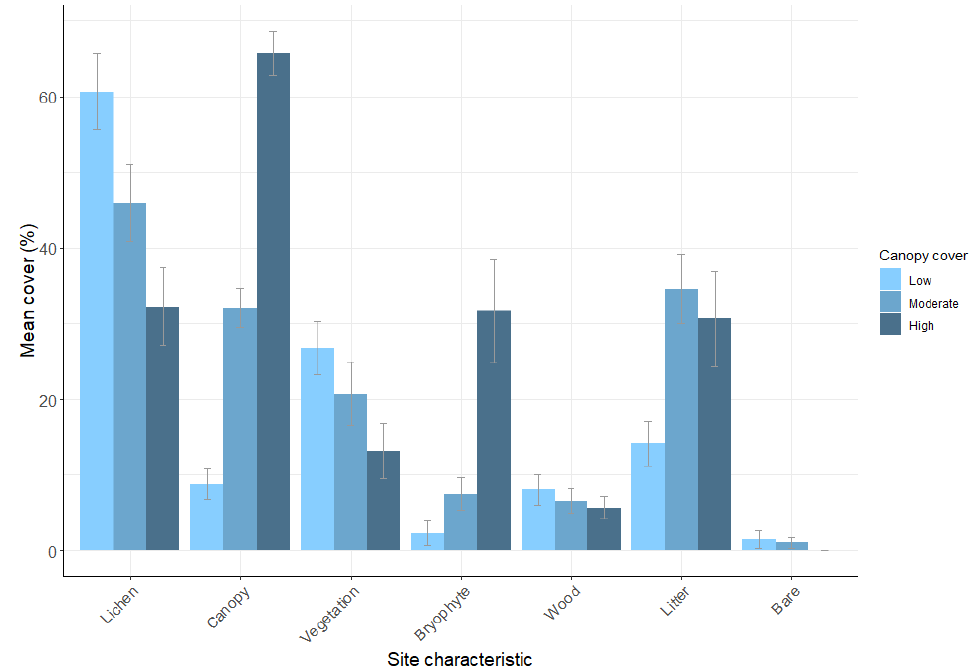
Figure 3. Plot characteristics for 15 jack pine forest stands, each with five subplots (75 total observations) sampled in the south boreal transition zone of Alberta, Canada. Mean and standard error (error bars) of plot characteristics for low ( < 25% canopy cover), moderate (25% to 50% canopy cover), and high ( > 50% canopy cover) plots.